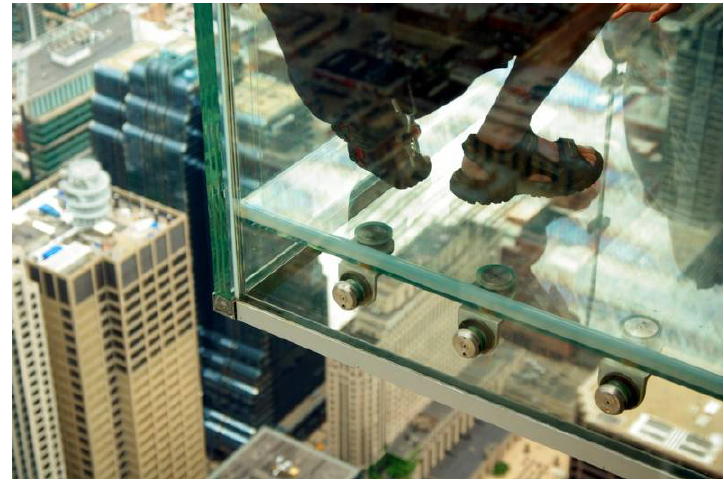
Figure 9: Typical glass connections. Heat tape strips are located inside the aluminum edge at the bottom.